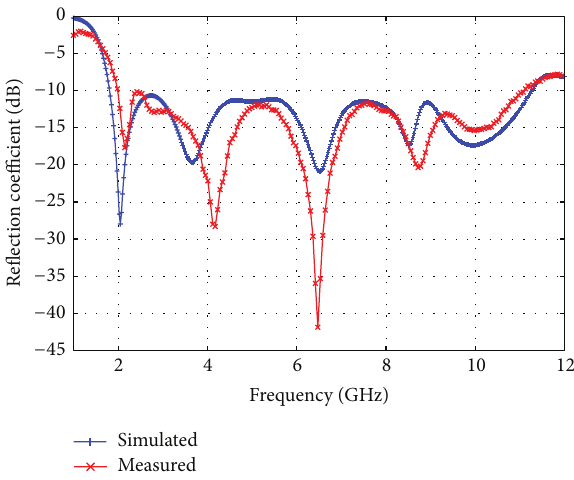
Figure 2: Reflection coefficient of the UWB antenna in Figure